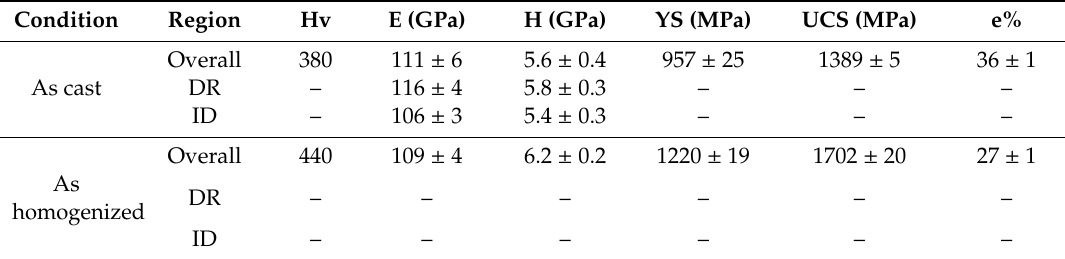
Table 3. Results of the Ti 25 Zr 25 Nb 25 Ta 25 alloy, obtained from the microhardness (Hv), nanoindentation (E and H), and compression testing (yield stress (YS), ultimate compressive strength (UCS), and failure compression strain e%) under the as-cast and as-homogenized